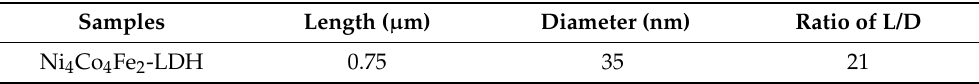
Figure 11. Morphology of Ni 4 Co 4 Fe 2 − LDH/NF after the stability test. Table 3. The parameters of Ni 4 Co 4 Fe 2 -LDH/NF after the stability test.